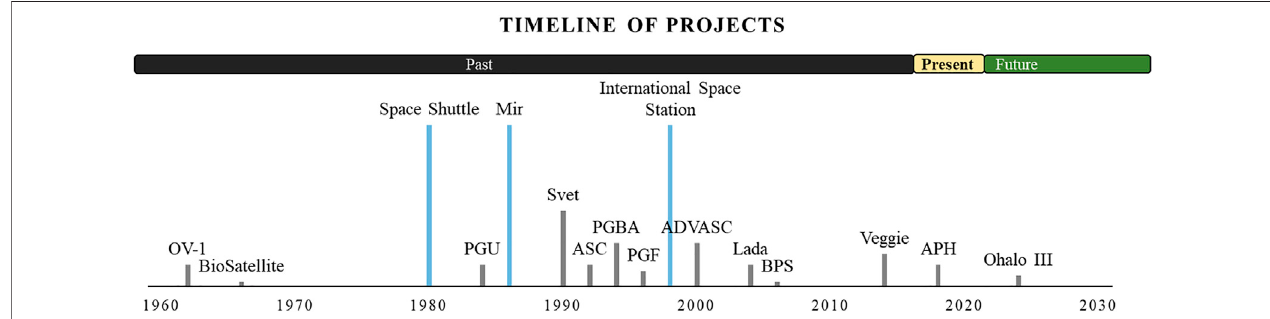
FIGURE 1 | Timeline of projects. Space fl ight hardware for bioregenerative crop production from 1960 – 2030. Past (black), present (yellow), and future (green) are indicatedabovethetimeline.Platformsareindicatedwithabluelinewhileplant-speci fi chardwareisindicatedbyagrayline.Lengthofthegraylinerepresentstherelative length of time that the hardware was/has been in operation. Orbital Vehicle 1 (OV-1; US Air Force), BioSatellite I and II (NASA), Plant Growth Unit (PGU; NASA), Svet (Roscosmos), Astroculture (ASC; Univ. Wisconsin/NASA), Plant Generic Bioprocessing Apparatus (PGBA; BioServe/NASA), Plant Growth Facility (PGF; NASA), Advanced Astroculture (ADVASC; Univ. Wisconsin/NASA), Lada (Roscosmos), Biomass Production System (BPS; NASA), Veggie (NASA), Advanced Plant Habitat (APH; NASA). Veggie and APH are currently in use on the International Space Station.